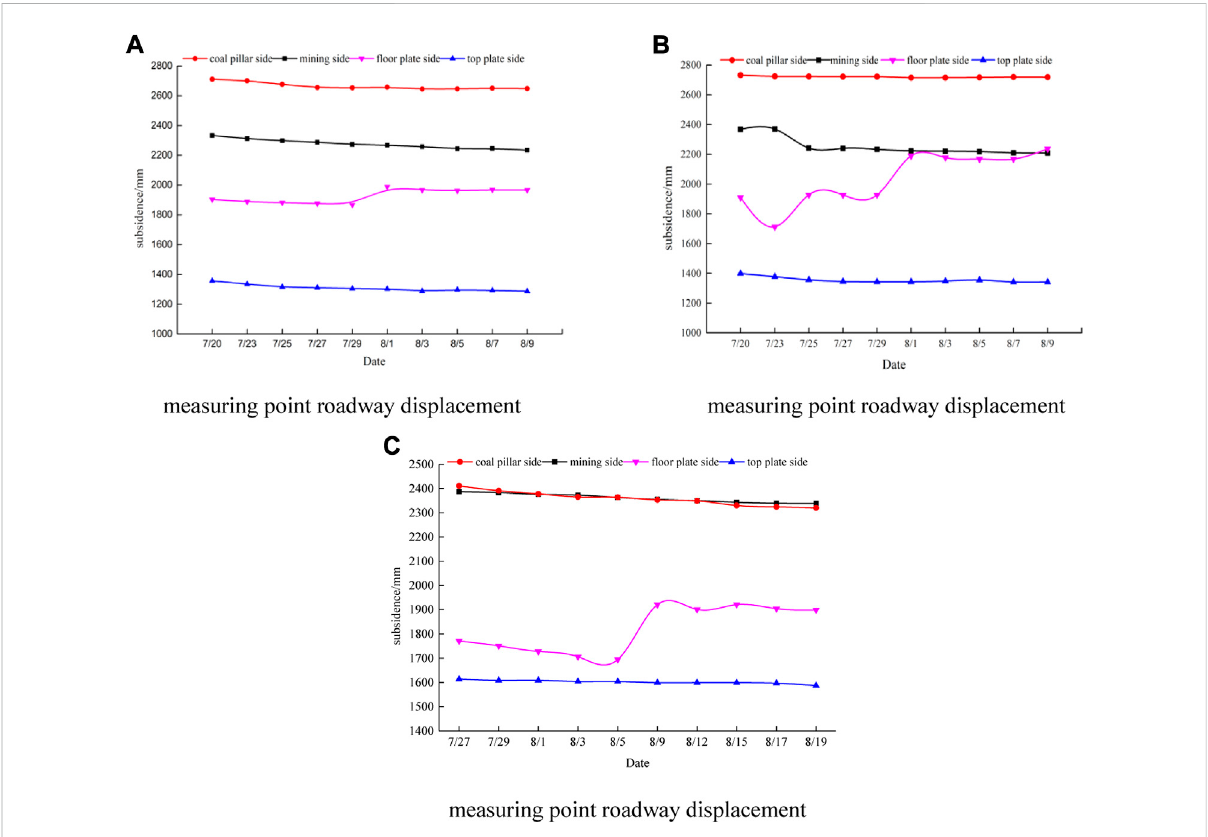
FIGURE 12 Displacement variation of the surrounding rock at each measurement point. (A) Measuring point roadway displacement of “ A ” . (B) Measuring point roadway displacement of “ B ” . (C) Measuring point roadway displacement of “ C ”